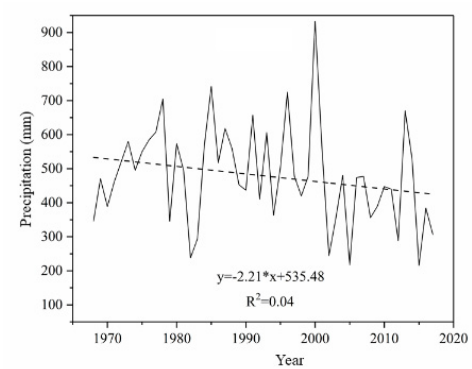
Figure 16. Trends in rainfall from 1968–2017 in the Nzhelele and Levuvhu river catchments.